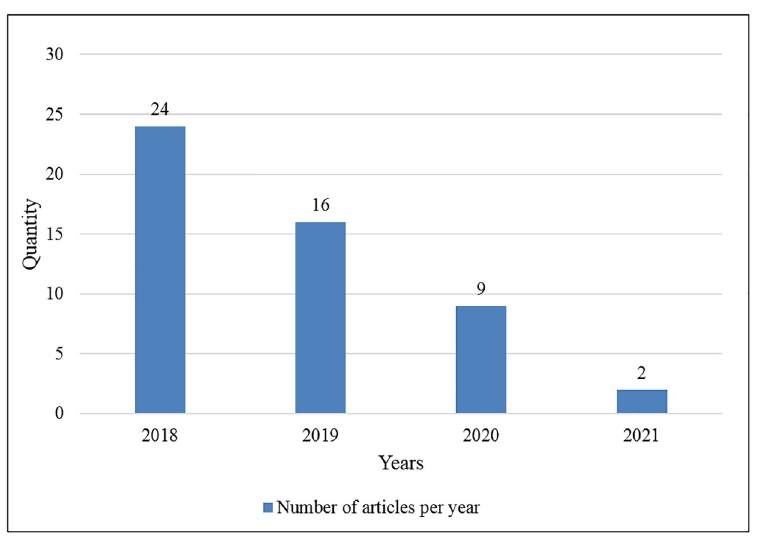
Fig 2. Number of articles published per year.